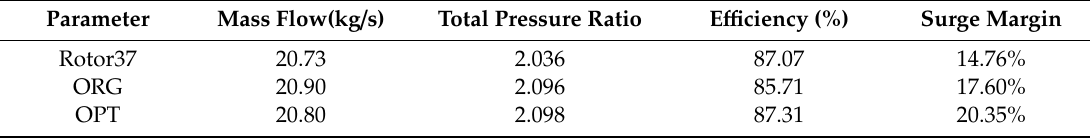
Figure 8. The cascade profile comparison of the original and optimized tandem rotor. ( a ) The hub section; ( b ) the middle section; ( c ) the tip section. Table 2. The performance comparison of Rotor37 and the original and optimized tandem rotor.